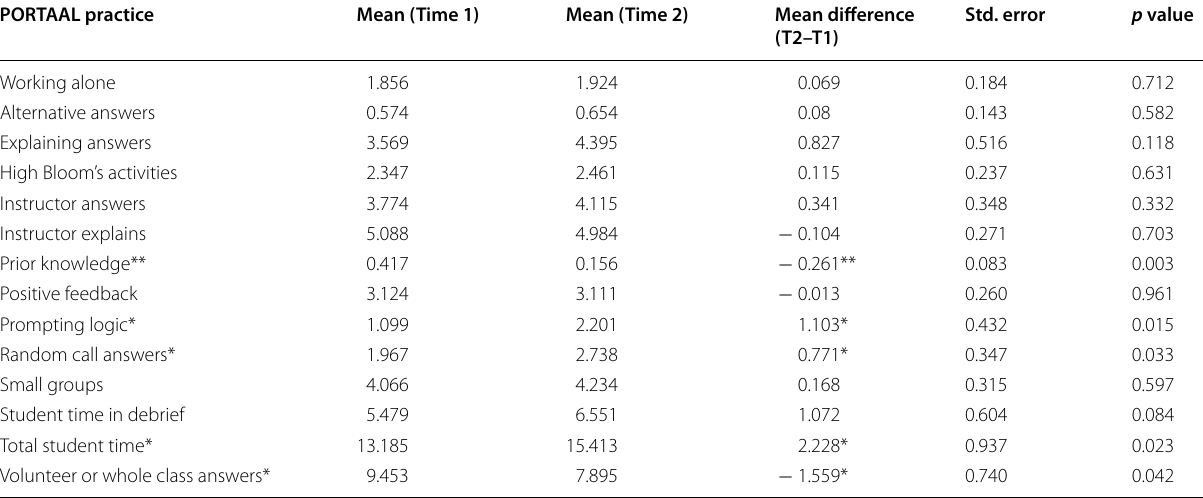
p values are Bonferroni adjusted for multiple comparisons. * p < 0.05. ** p < 0.01. *** p < 0.001